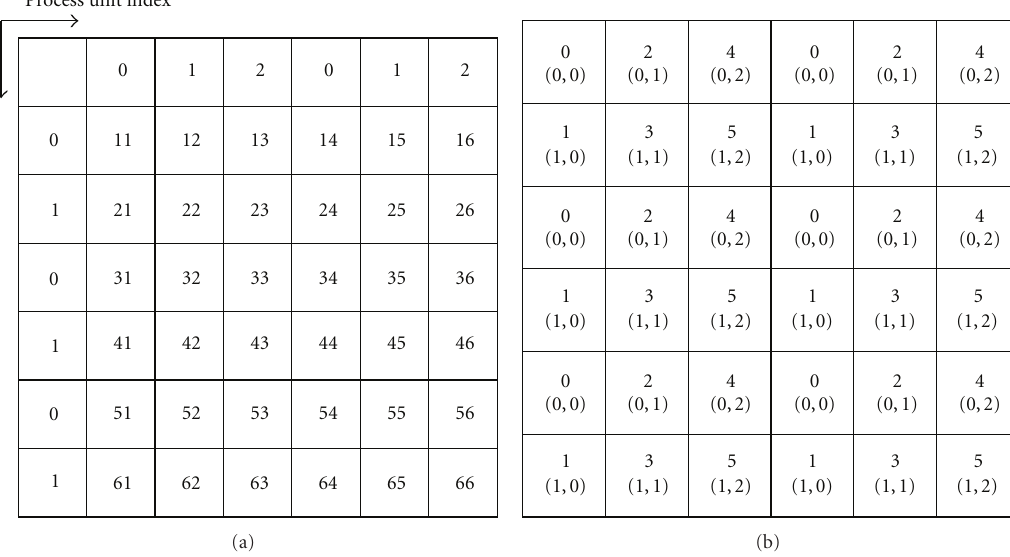
Figure 2: Block-cyclic distribution of a matrix [4]: (a) a matrix consisting of 6 × 6 blocks; (b) rank and coordinates of each process owning the corresponding blocks in